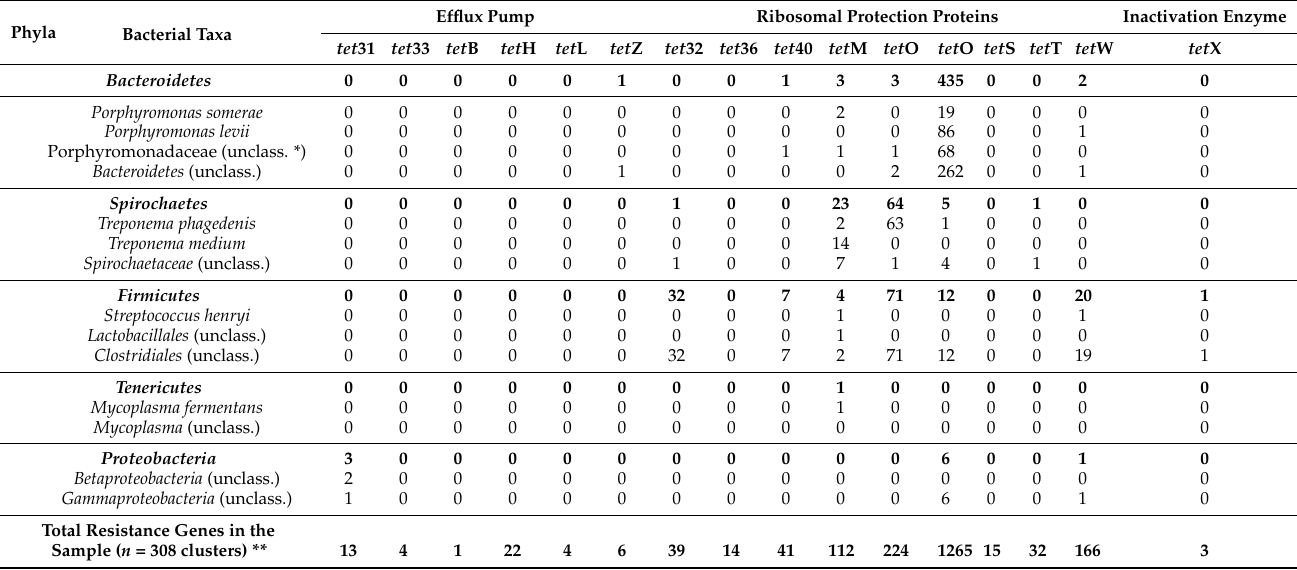
Table 3. Types and distributions of tetracycline resistance genes in bacterial taxa having ≥ 80% complete genome detected in digital dermatitis lesions.